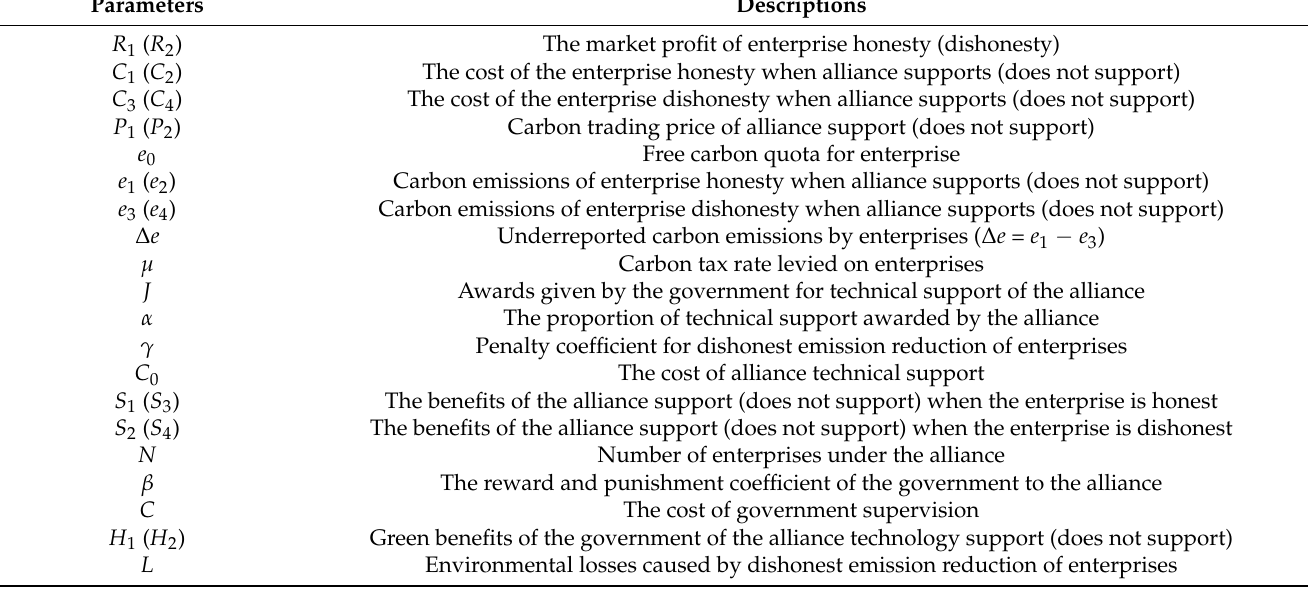
Table 1. Parameters’